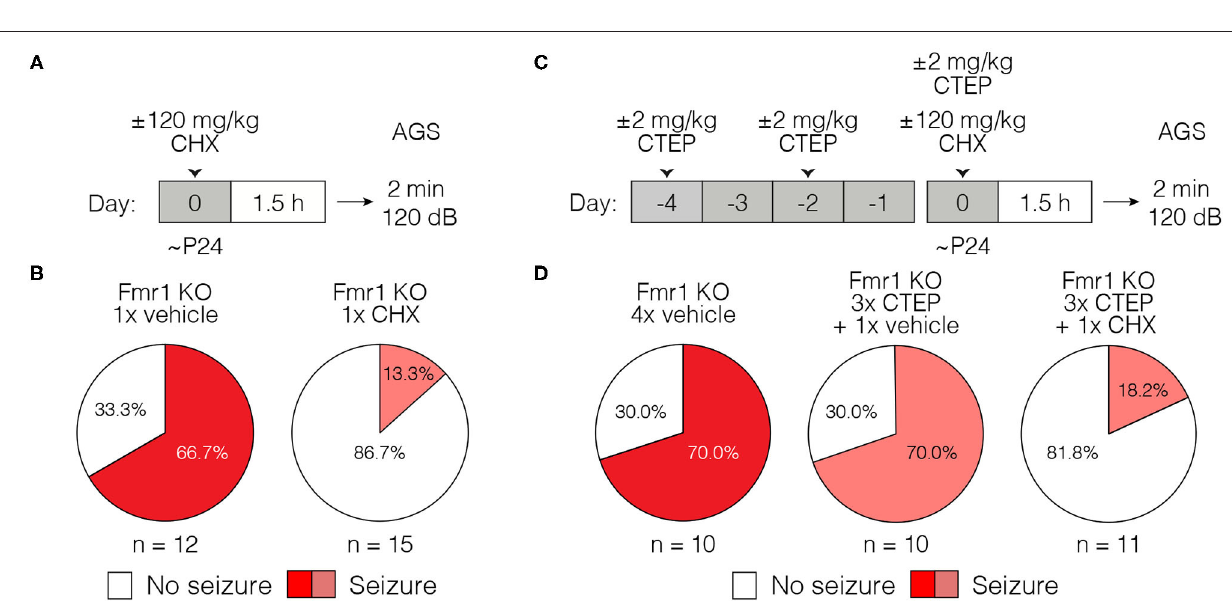
FIGURE 2 | Acute cycloheximide treatment ameliorates audiogenic seizures in Fmr1-KO mice and overcomes acquired CTEP resistance. (A) Schematic shows acute CHX dose schedule and AGS experimental design. (B) Acute treatment with 120 mg/kg CHX significantly reduced AGS incidence in Fmr1-KO mice (Two-tailed Fisher’s exact test: p = 0.0069). (C) Schematic shows acute cycloheximide after chronic CTEP dose schedule and AGS experimental design. (D) Chronic CTEP (3 doses of 2 mg/kg over 5 days) causes treatment resistance that can be overcome by an acute injection of 120 mg/kg CHX immediately prior to assessing AGS